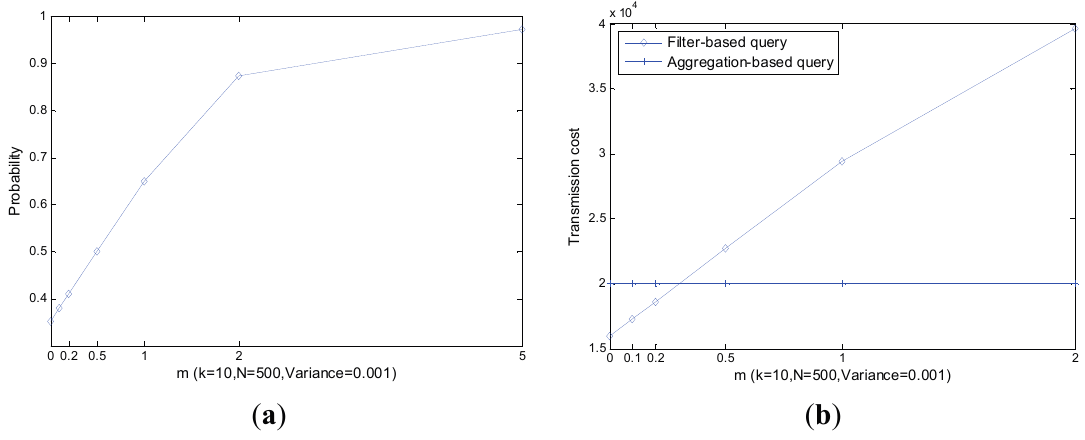
Figure 11. (cid:1842)(|leave| > |join|) and corresponding transmission cost with the decreasing of readings’ range. ( a ) (cid:1842)(|leave| > |join|) ; ( b ) Transmission